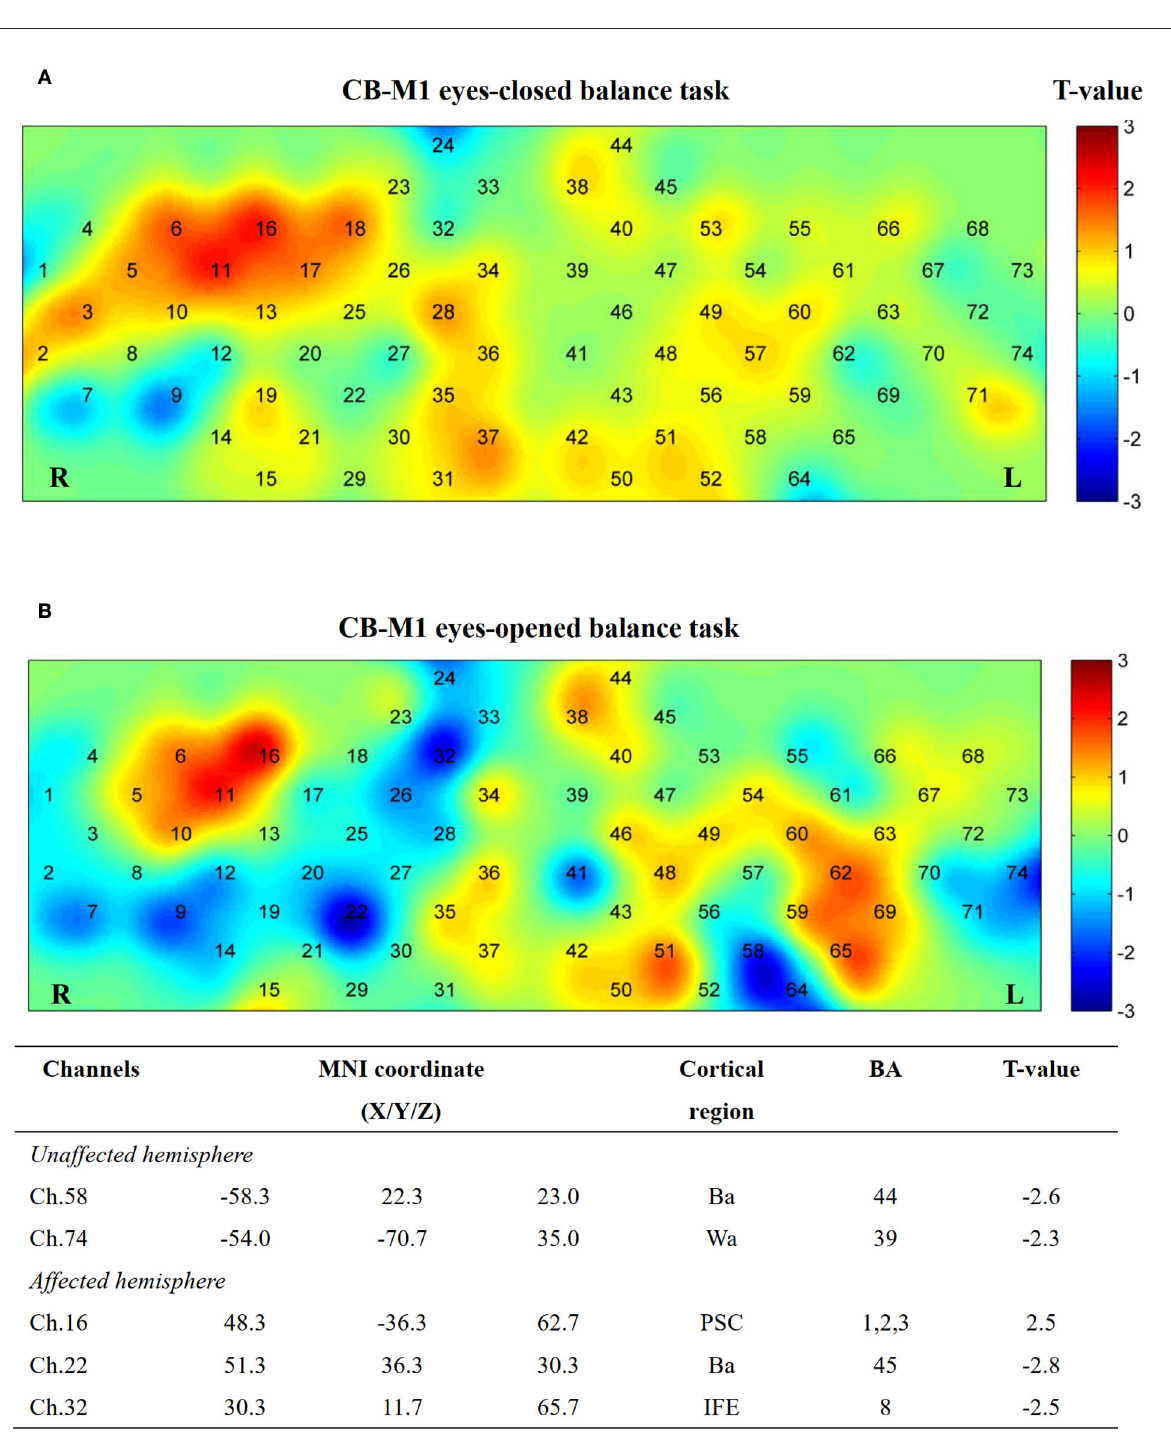
the sensorimotor information flow along the CTC pathway including the red nucleus and olive (15, 41), resulting in a better balance of somatosensory feedback and faster process speed to